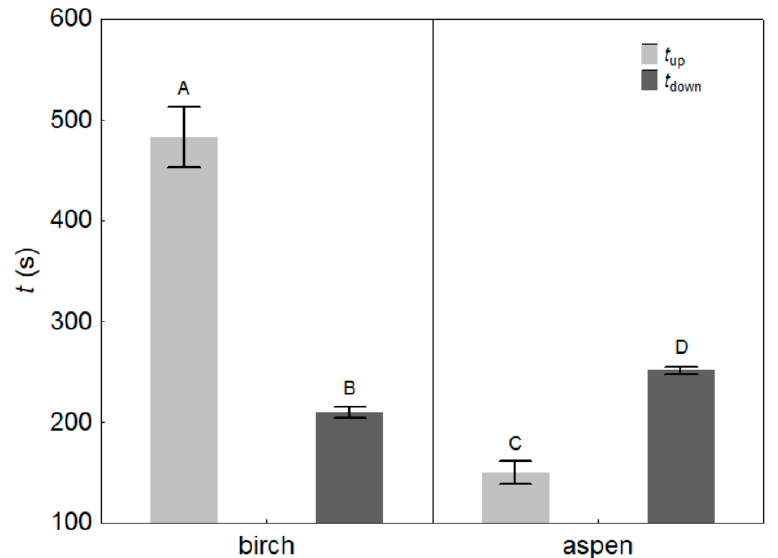
Figure 3. Mean values ( ± SE) of the up- ( t up ) and down-regulation ( t down ) times of leaf hydraulic con-